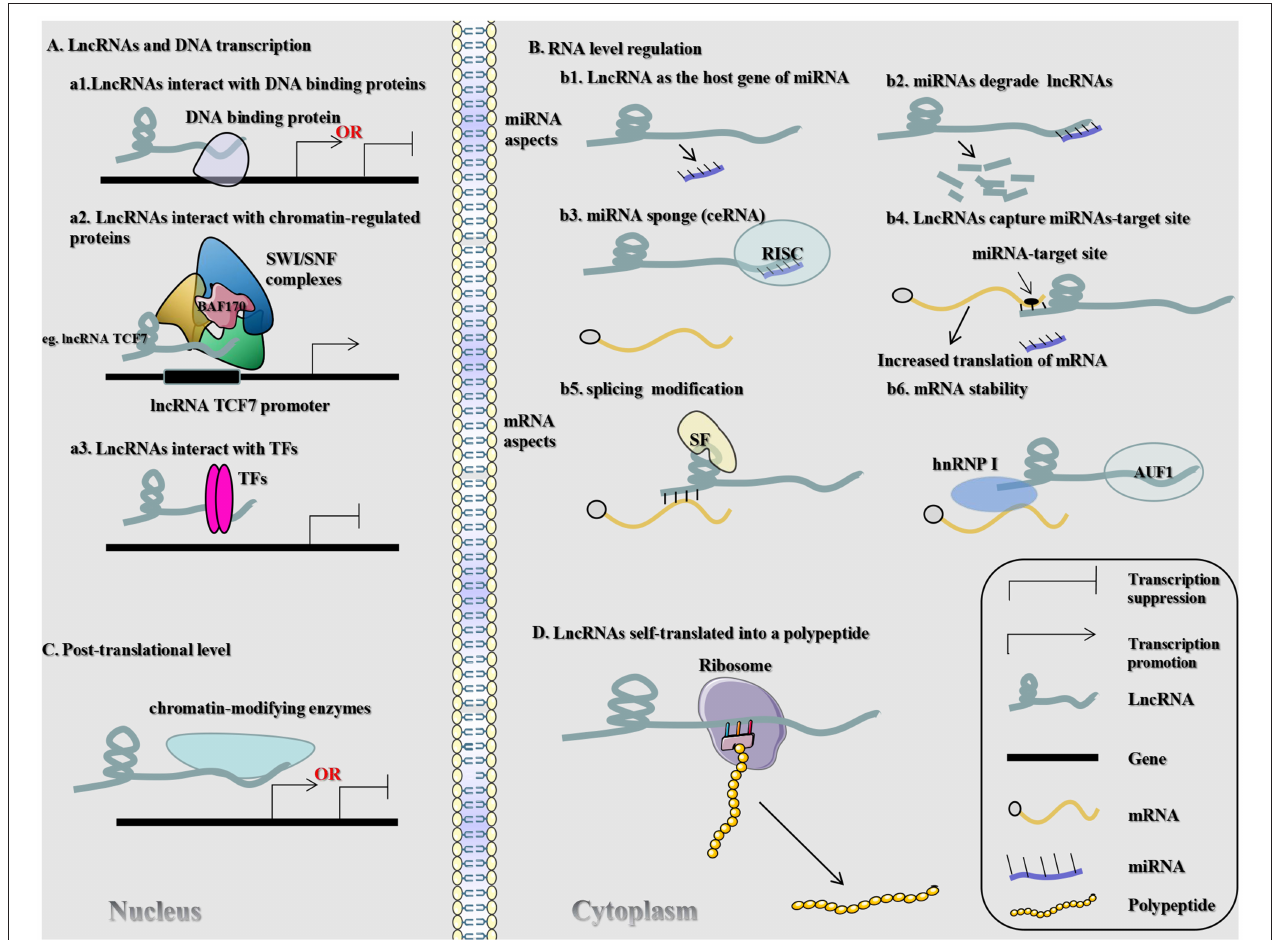
FIGURE 3 | Signaling mechanisms of lncRNAs engaged in autophagy in CRC. LncRNA HAGLROS (H19) as ceRNA sponges miR-100 (miR-194-5p) to repress the degradation of ATG5 (SIRT1) mRNA by miR-100 (miR-194-5p), thereby accelerating autophagy and inhibiting the proliferation of CRC